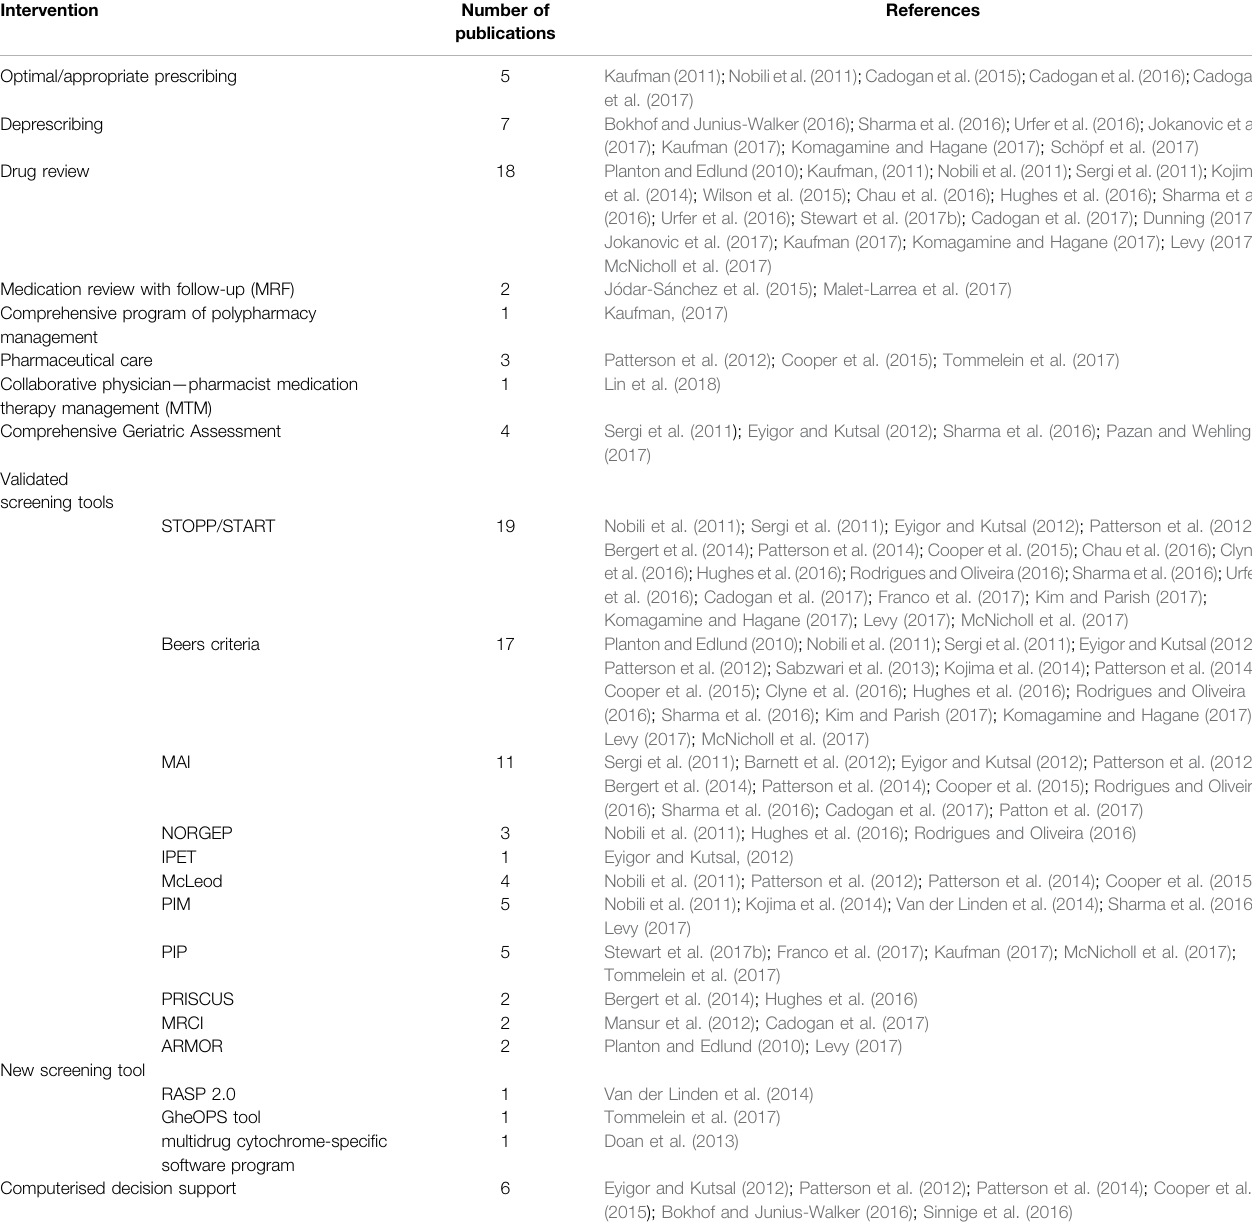
TABLE 2 | Polypharmacy interventions identi fi ed in reviewed